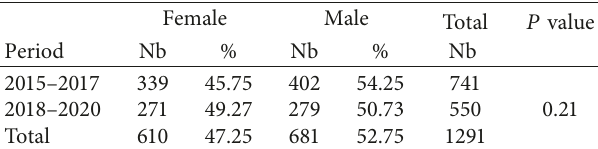
Table 1: Comparison between the admission periods and the genders.